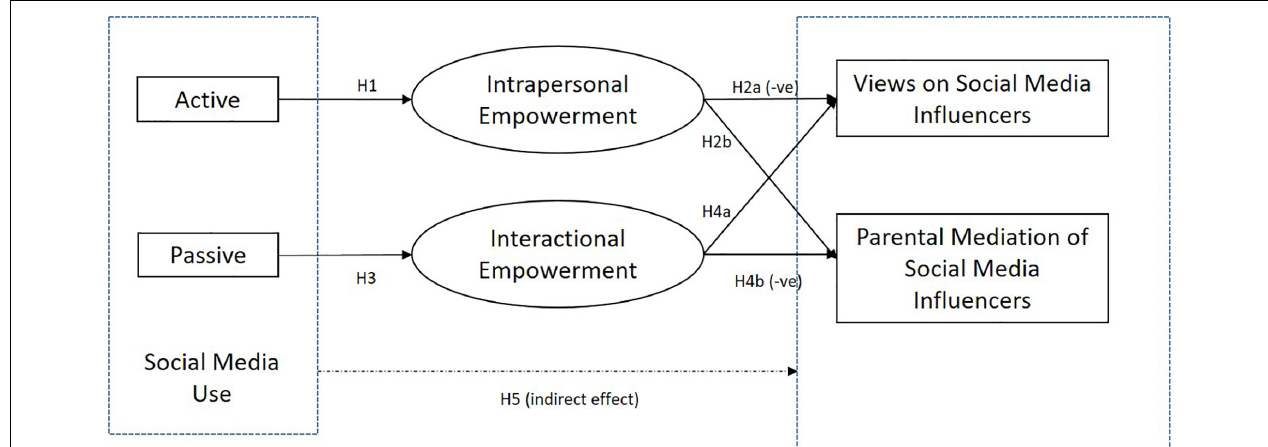
FIGURE 1 | Proposed